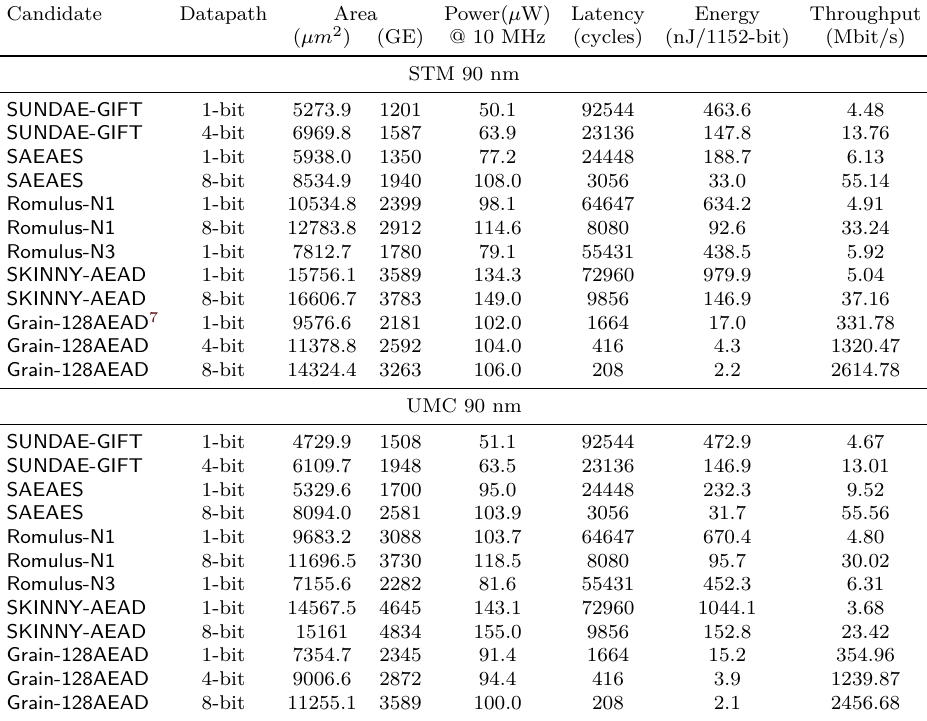
Table 12: Synthesis figures for selected AEAD Schemes in STM 90 nm and UMC 90 nm libraries. Energy and throughput are based on 1024 bits of plaintext and 128 bits of